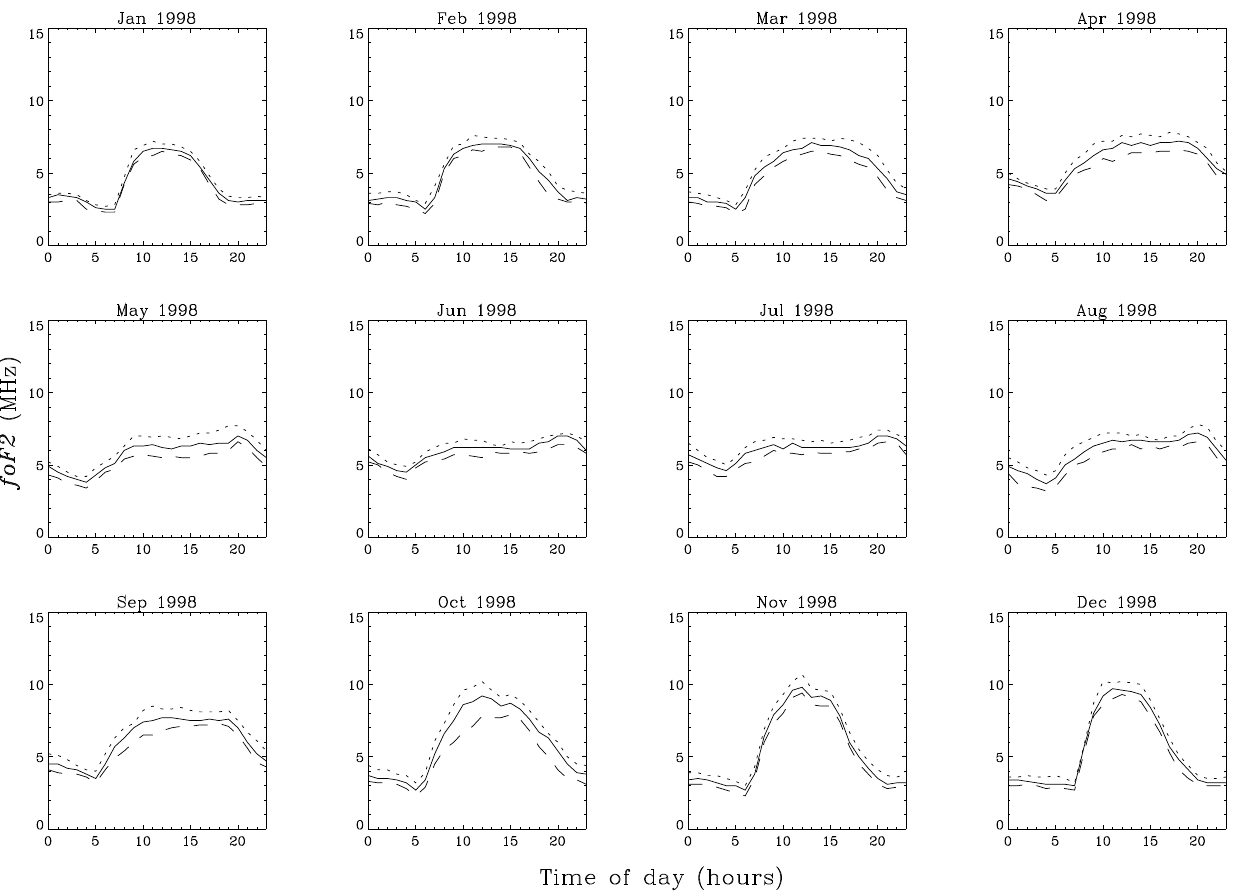
Fig. 3. Monthly median fo F2 values for the year 1998 (solid line). Dashed and dotted lines represent the upper and lower quartiles,